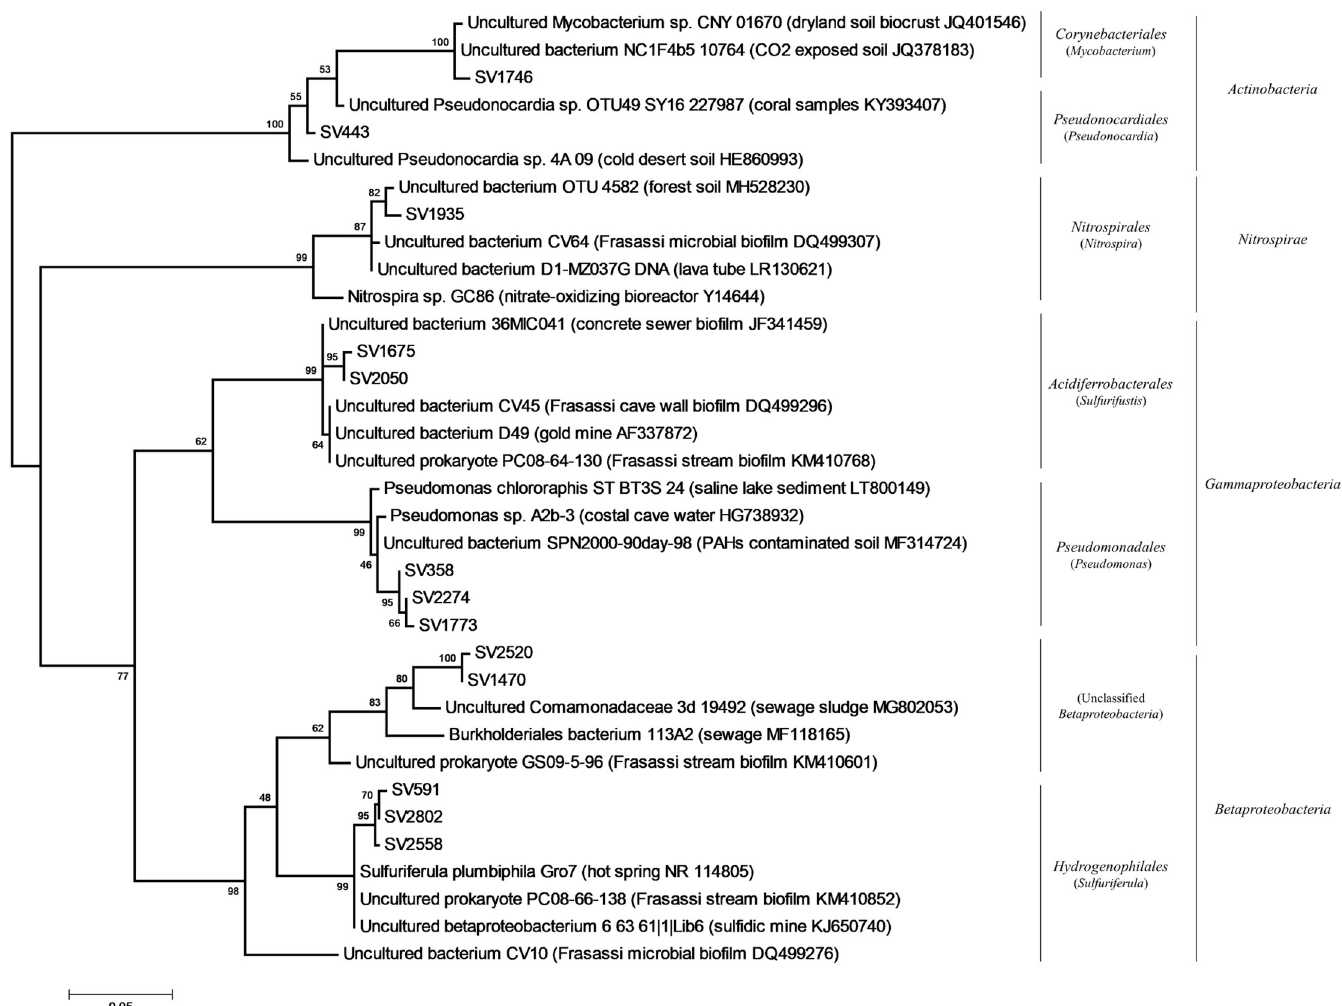
Fig 11. Phylogenetic tree of the most abundant SVs in V-grey (colored in grey) and V-brown (colored in brown) samples. For taxonomy details and Best Blast Hit of the SVs reported, see S7